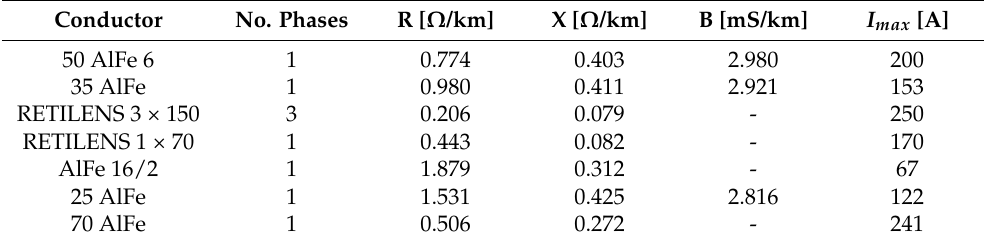
Table 1. Electrical parameters of used